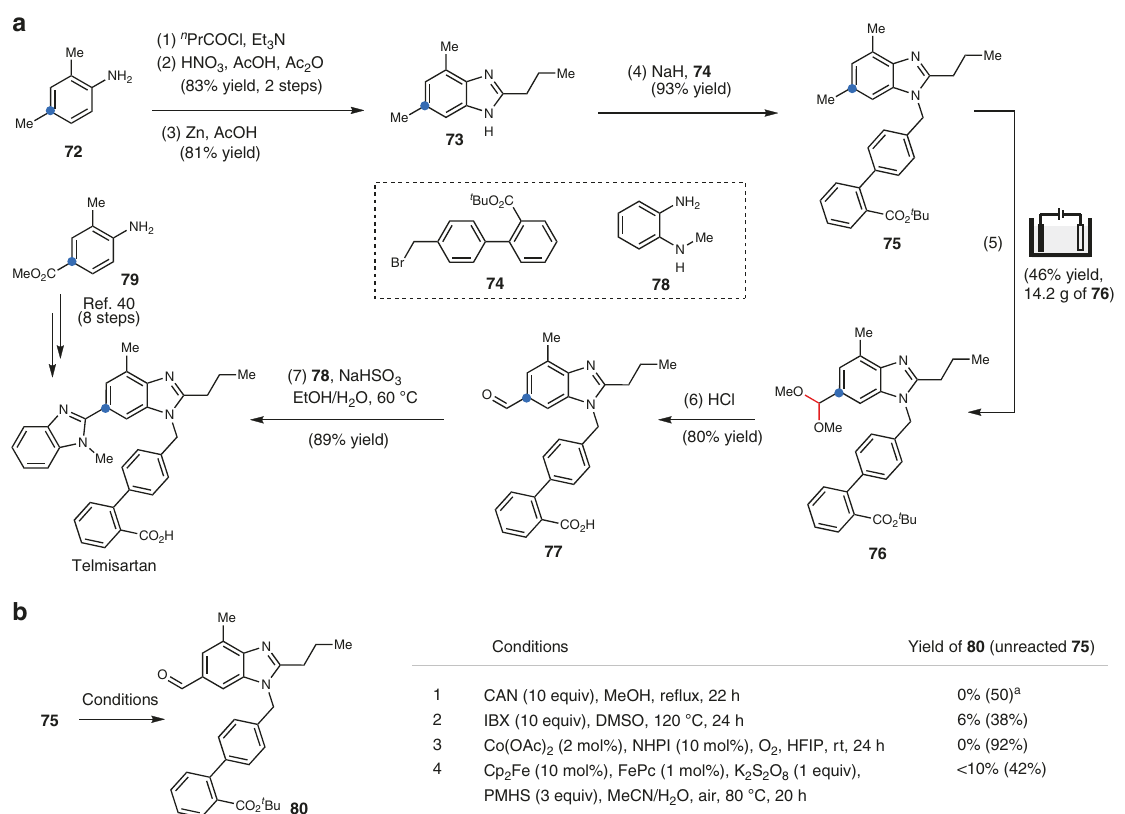
Fig. 5 Synthesis of telmisartan. a Our synthetic route employing site-selective benzylic electrooxidation as a key step. b Oxidation of 75 under reported conditions for benzylic oxidation. a Me ester was recovered instead of the original t Bu ester 75 because of transesteri fi cation. NHPI N-Hydroxyphthalimide, Fe(II)Pc iron(II)